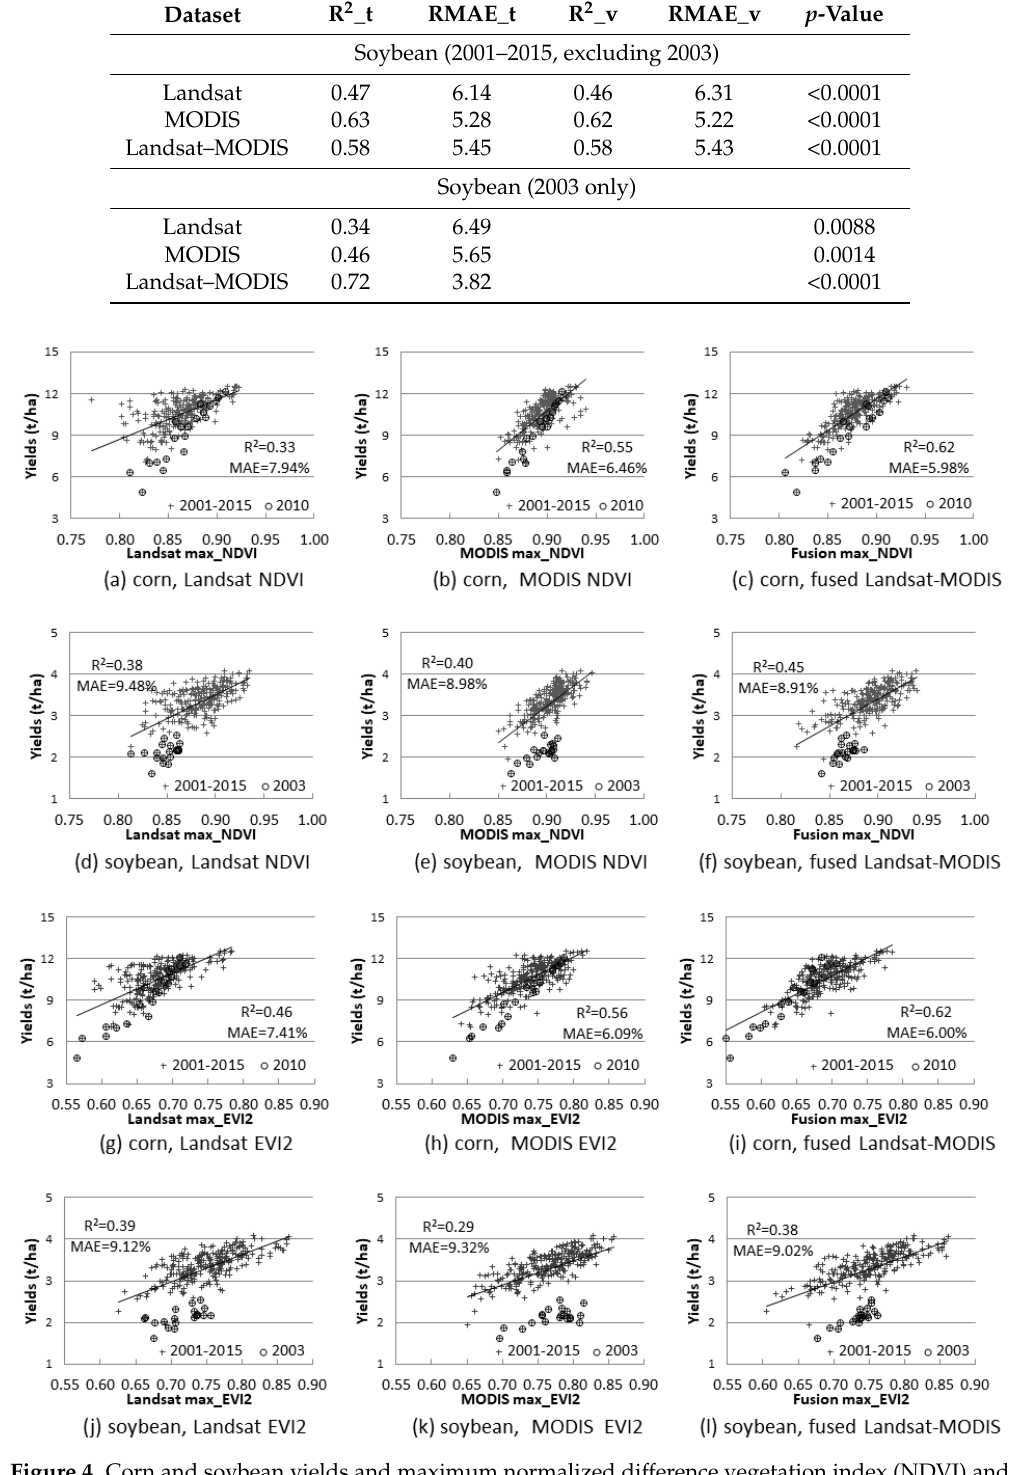
Figure 4. Corn and soybean yields and maximum normalized difference vegetation index (NDVI) and maximum two-band enhanced vegetation index (EVI2) for each county and year using Landsat only ( left ), MODIS only ( middle ), and Landsat–MODIS data fusion results ( right ). The fused data showed better explanatory ability even at the very coarse county level. The circles show samples from the flood year (2010) for corn ( a – c , g – i ) and the drought year (2003) for soybean ( d – f , j – l ). Statistics in the plots were computed using all available samples.